Question: Author a descriptive caption for the visualization shown.
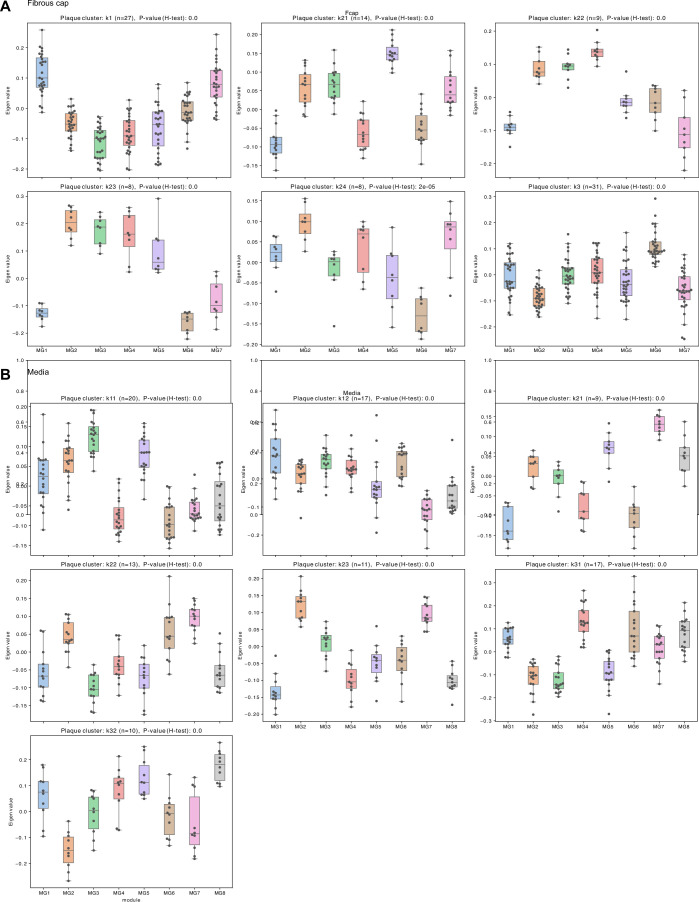
Answer: Plaque subregions show distinct proteomic and inferred cellular programs. a , Principal component analysis of plaque proteomes ( n = 318 samples) showing separation by histomorphological subregion (media, necrotic core and fibrous cap); shading indicates subregion-specific clusters. b , Subregion-specific protein abundance patterns across functional gene-set categories. Solid lines indicate median protein intensity, and shaded ribbons denote ±2 s.d.; the gray band shows the overall ±2 s.d. across all samples. c , Differential protein abundance between paired subregions ( q < 0.05, |log 2 fold change | >1) identifies distinct molecular signatures. Lower panels show inferred cell-type enrichment based on marker proteins; significance was assessed by bootstrap testing. d , Network representation of enriched biological processes across plaque subregions. Nodes represent enriched terms, with pie charts indicating subregional contribution, and edges connect related pathways on the basis of shared proteins. MHC, major histocompatibility complex. Source data